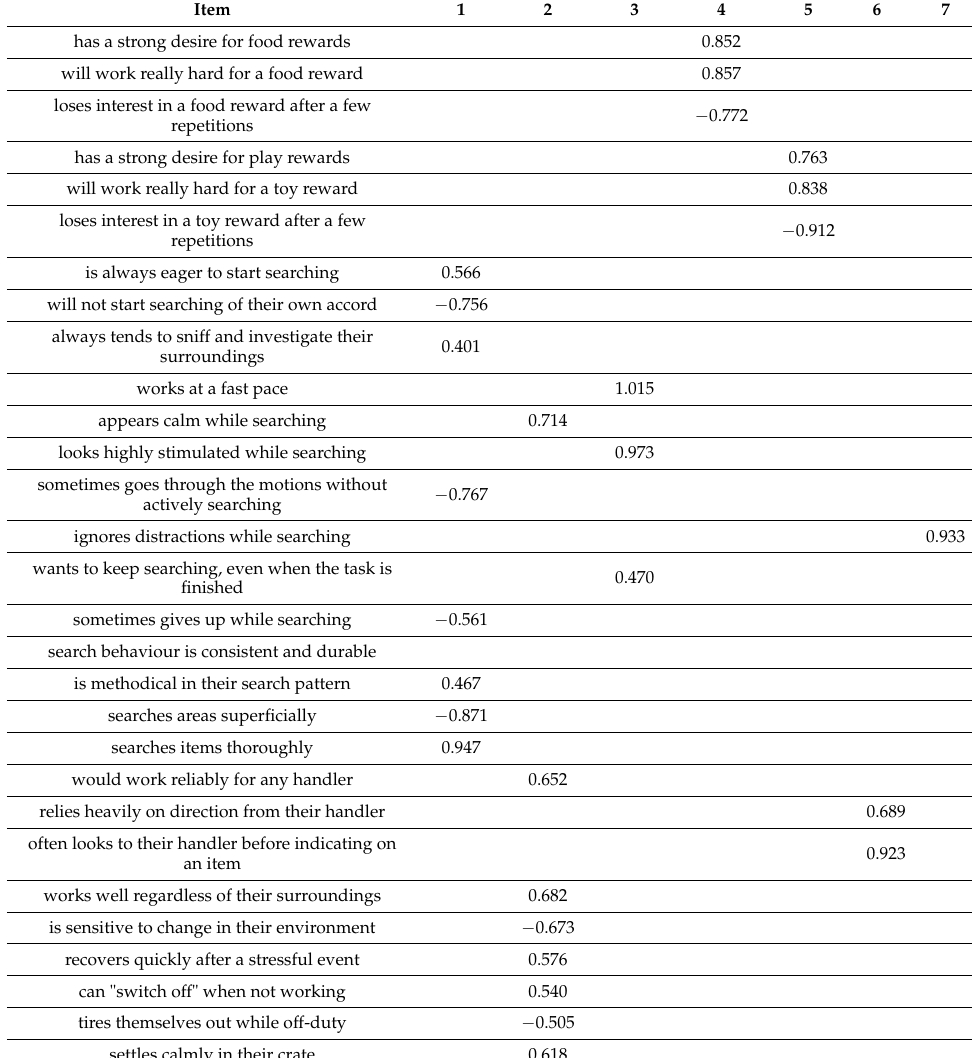
Table 3. Factor loadings for each work behaviour questionnaire item. Loadings of <0.4 are not